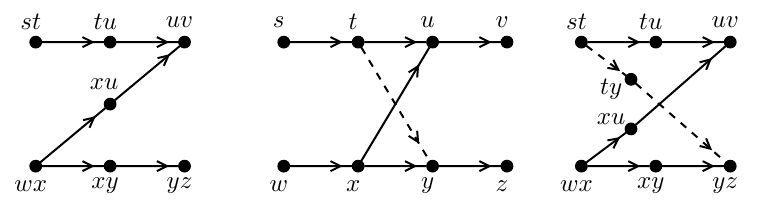
Figure 25: Levels in